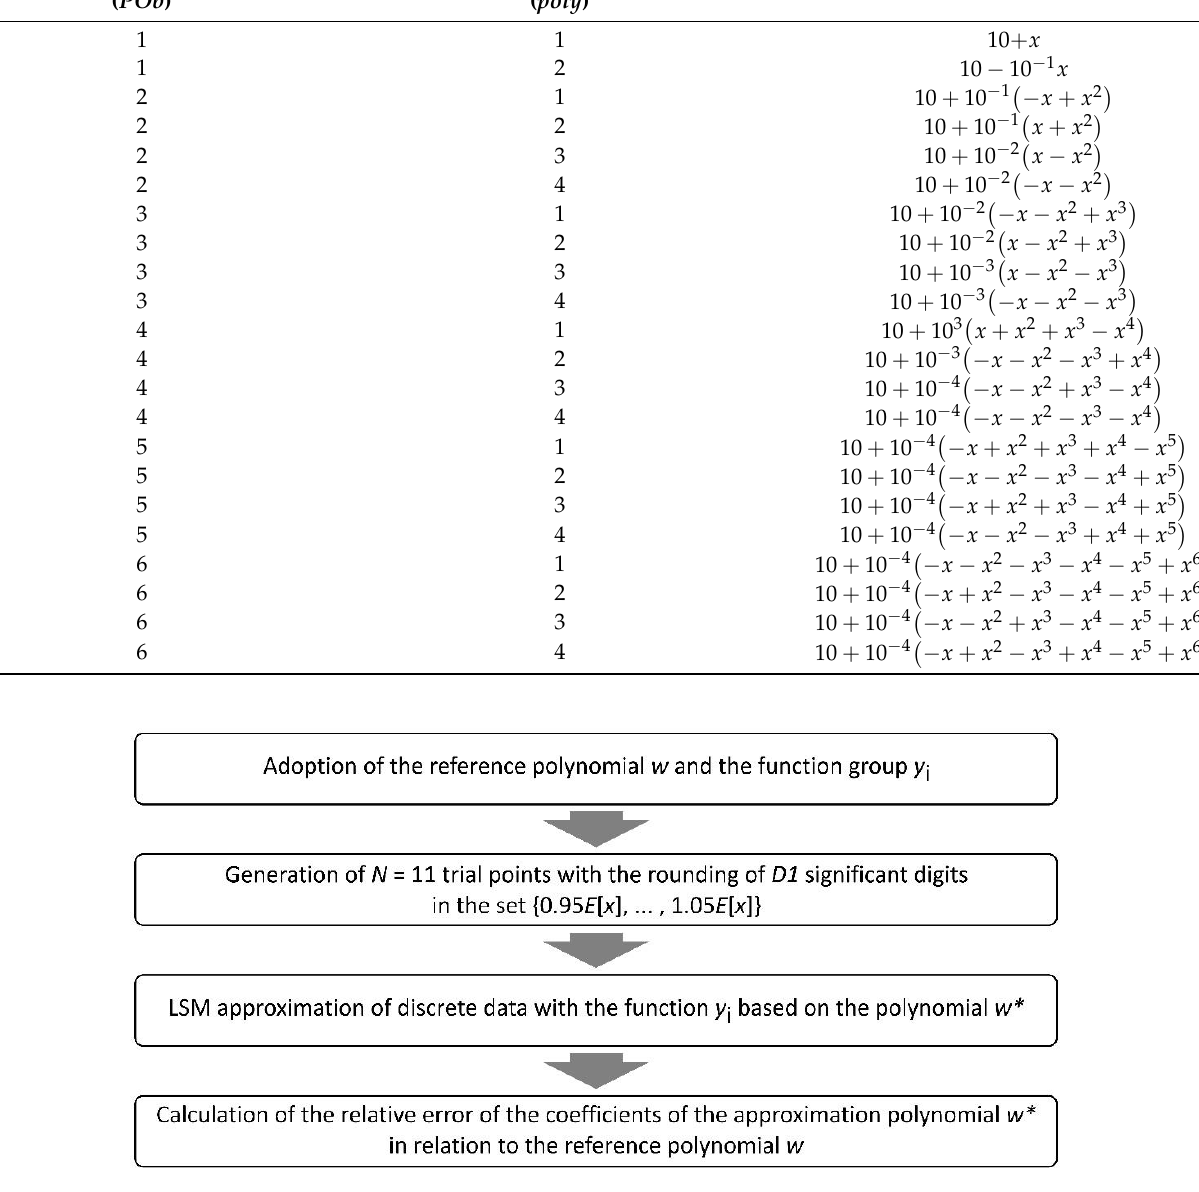
Figure 3. Scheme of the first part of the experiment.